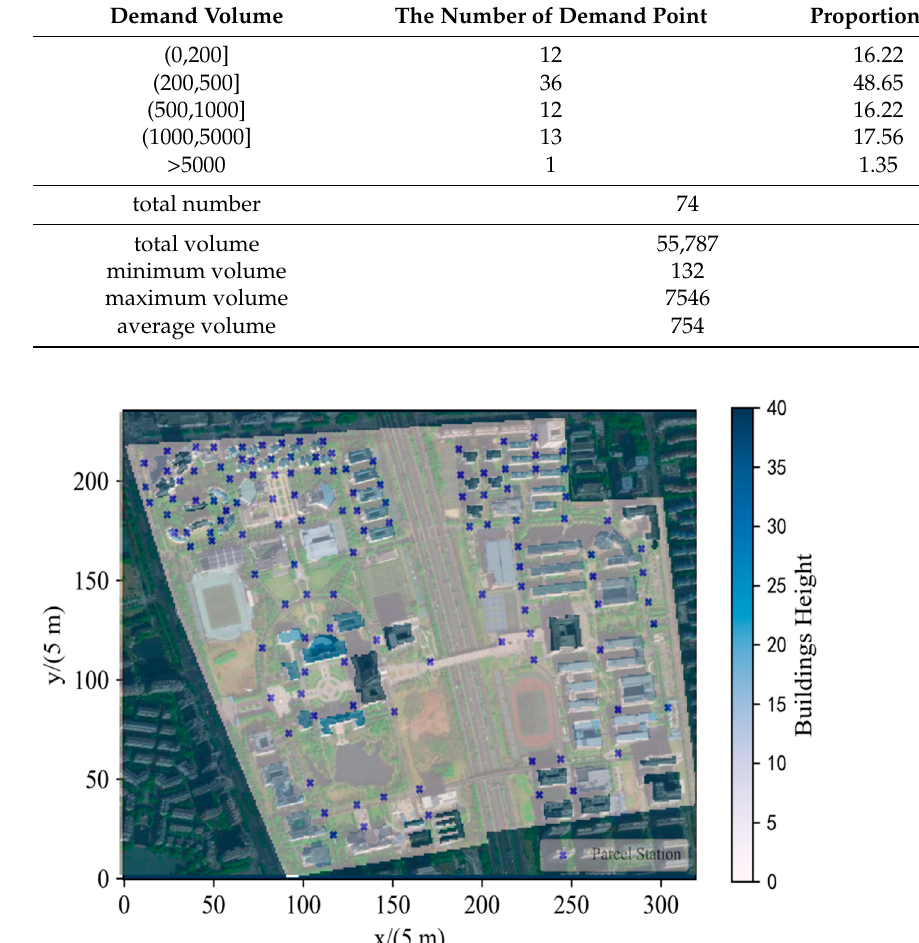
Figure 10. Alternative locations of the package-receiving station. Table 5. Distribution and volume of logistics demand.